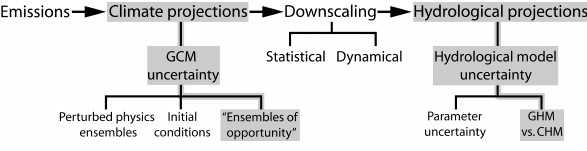
Fig. 1. The four stages of a climate change hydrological impact assessment and the inherent uncertainties. The shaded areas denote the uncertainties we considered in this